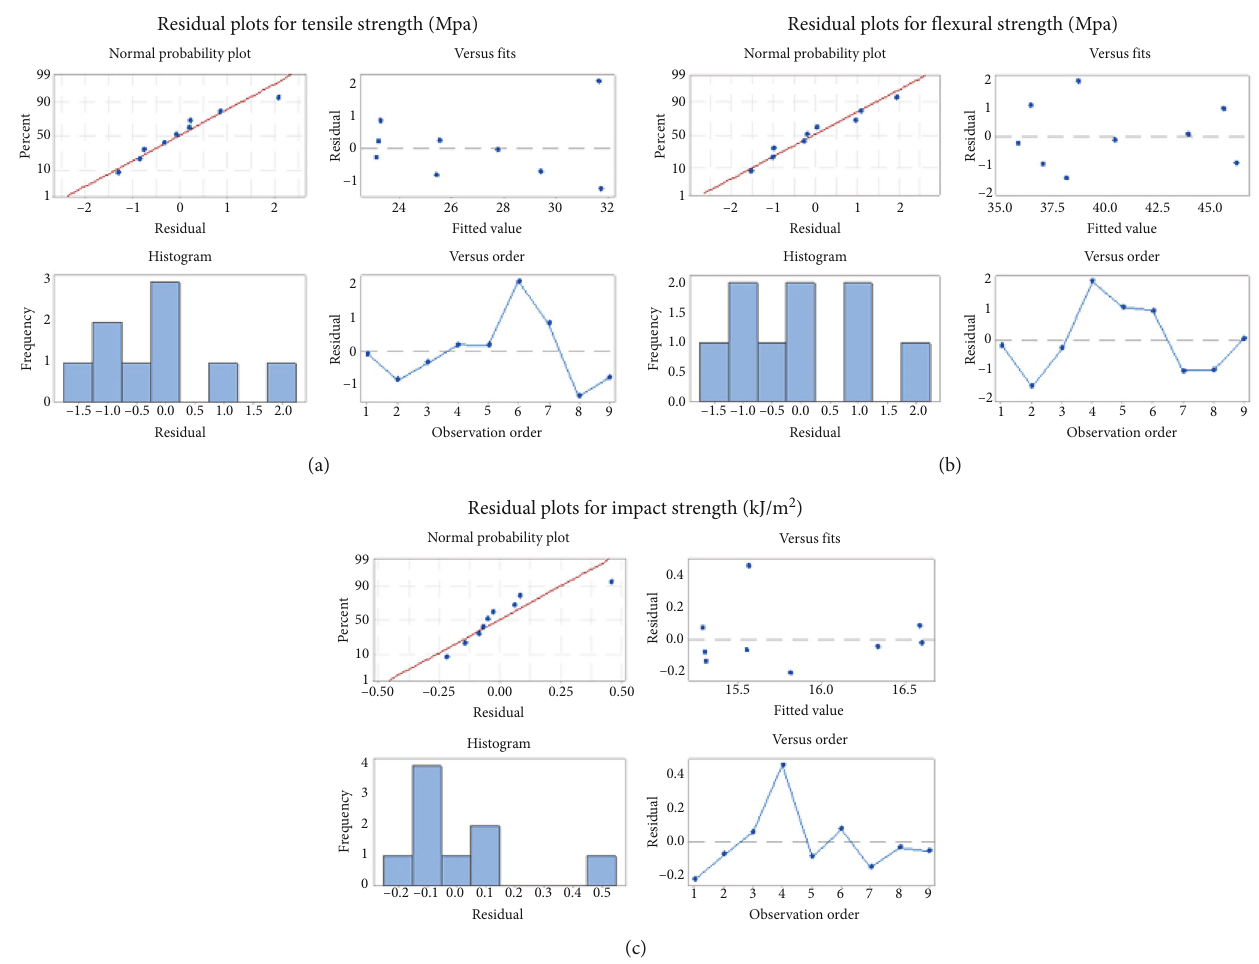
Figure 4: Residual plots for (a) tensile strength, (b) fl exural strength, and (c) impact